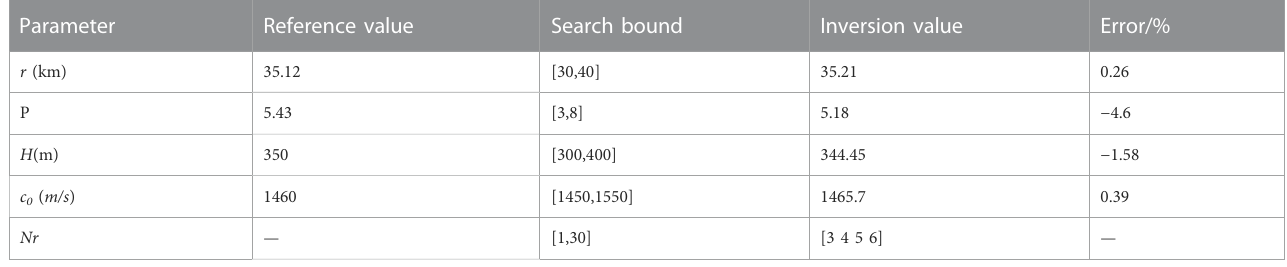
TABLE 3 Inversion parameter list of measured data 2.